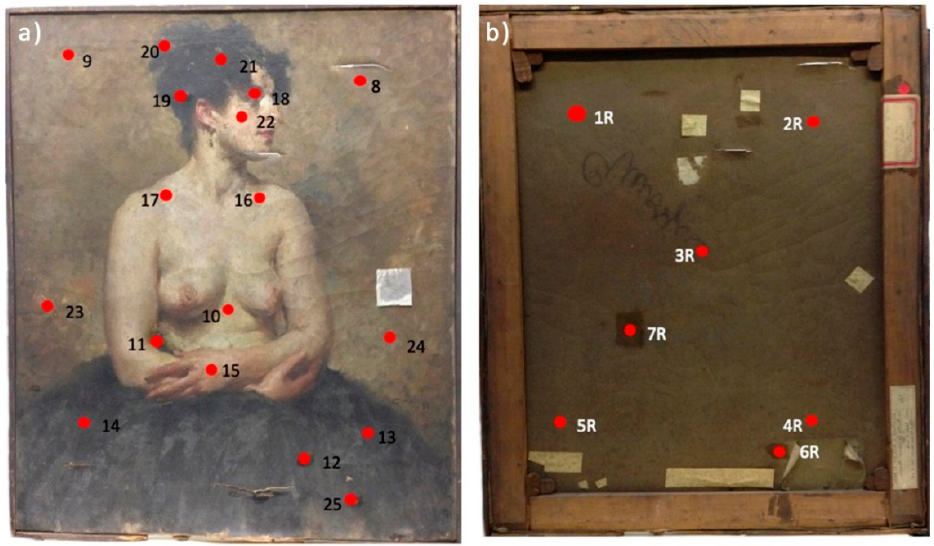
Figure 1. The artwork “Studio di nudo” and position of sampling points from observe ( a ) and reverse ( b ) sides of the canvas. ( b ) sides of the